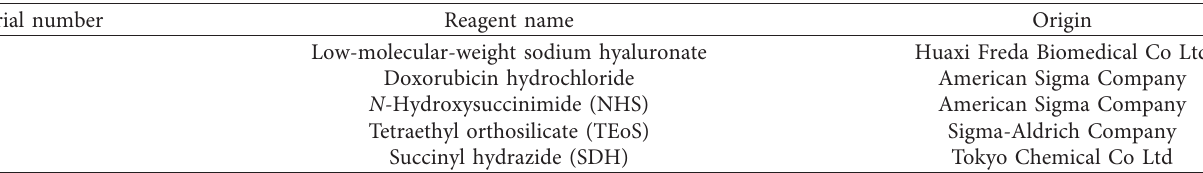
Table 1: Main reagents.